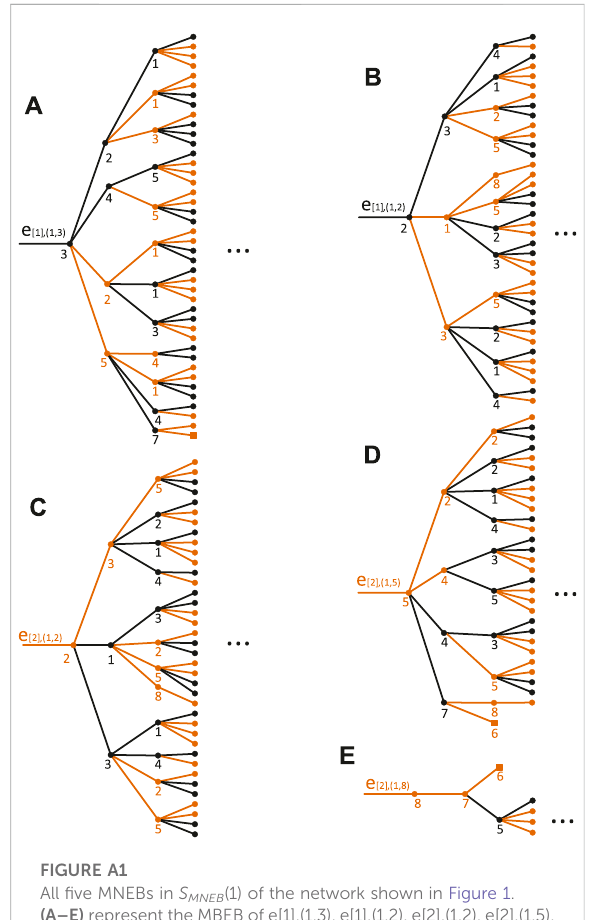
All fi ve MNEBs in S MNEB (1) of the network shown in Figure 1. (A – E) represent the MBEB of e[1],(1,3), e[1],(1,2), e[2],(1,2), e[2],(1,5), e[1],(1,8),